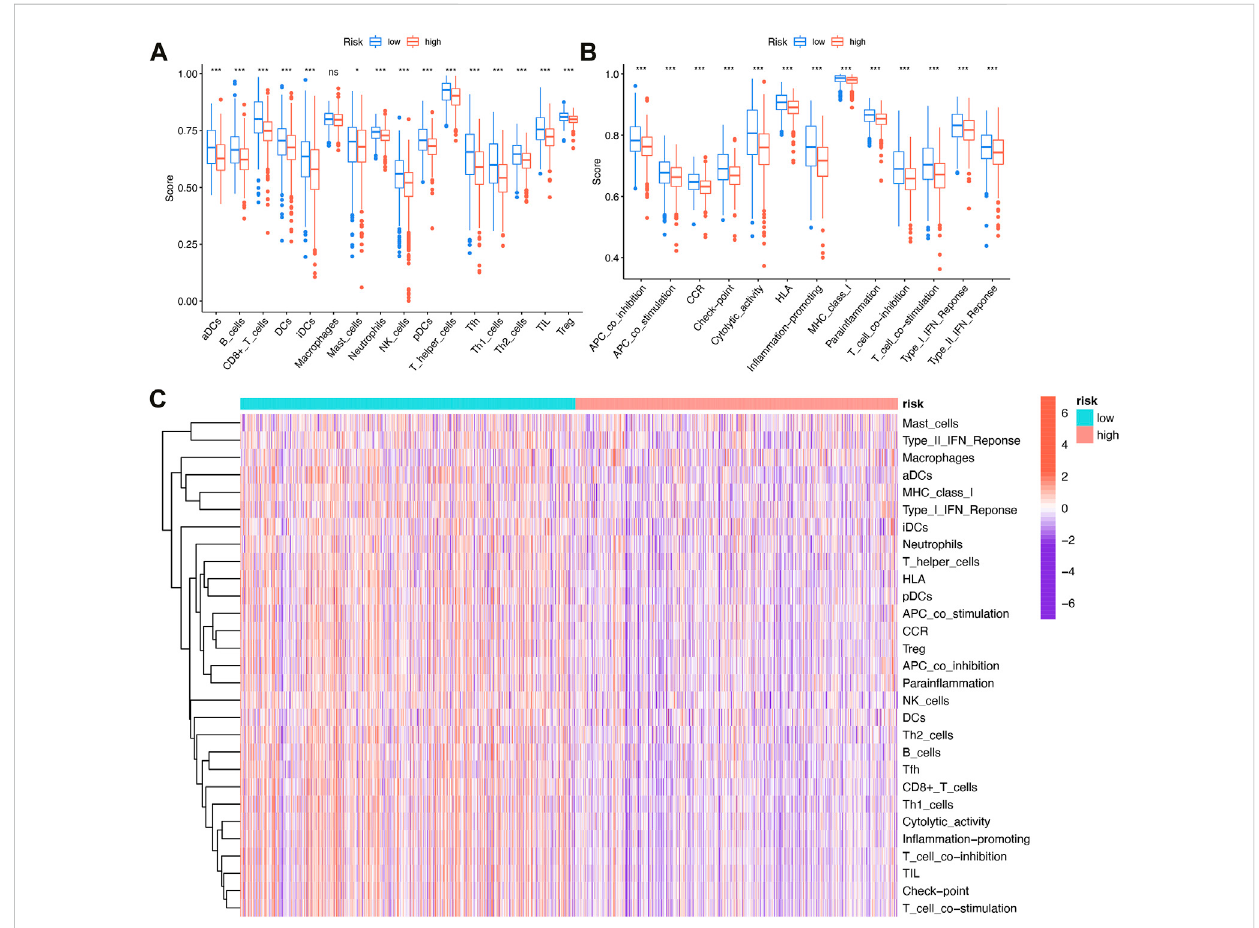
FIGURE 6 Relationship with immune in fi ltration (A) Boxplot of association between IFRSig and immune cell lineage; (B) Boxplot of association between IFRSig and immune function; ANOVA used as signi fi cance test, * p < 0.05, ** p < 0.01, *** p < 0.001. (C) Immune correlation